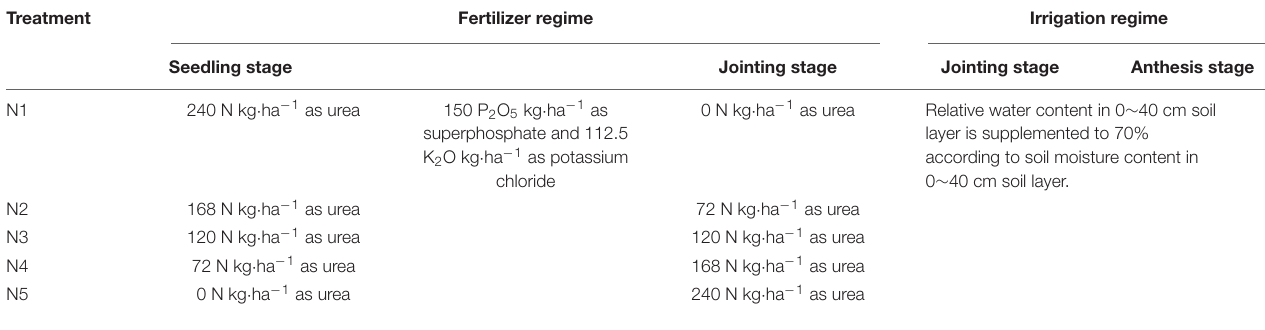
TABLE 1 | Agronomic managements under different split nitrogen fertilizer treatment.